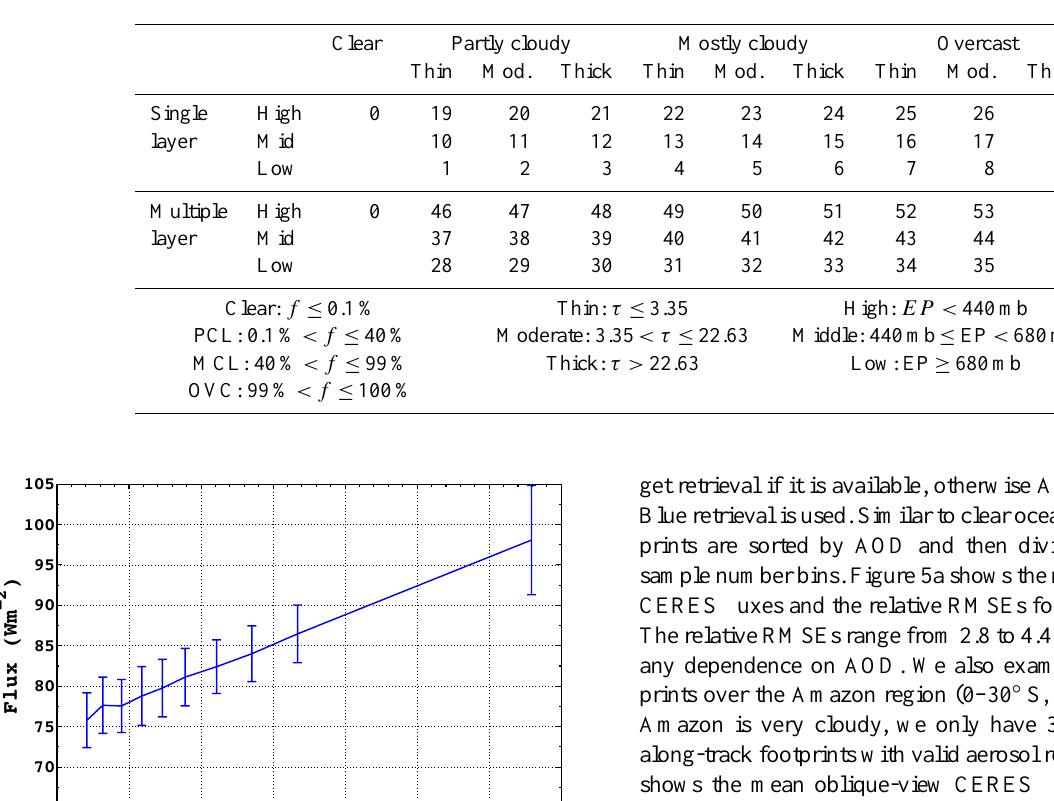
Table 4. Cloud type classification used in TOA flux consistency tests. Each CERES footprint is assigned a scene identification index from 0 to 54 based upon cloud fraction ( f , in %), mean effective cloud top pressure (EP), and cloud optical depth ( τ ), and whether one or two cloud layers are observed within the footprint. PCL: partly cloudy; MCL: mostly cloudy; and OVC: overcast.